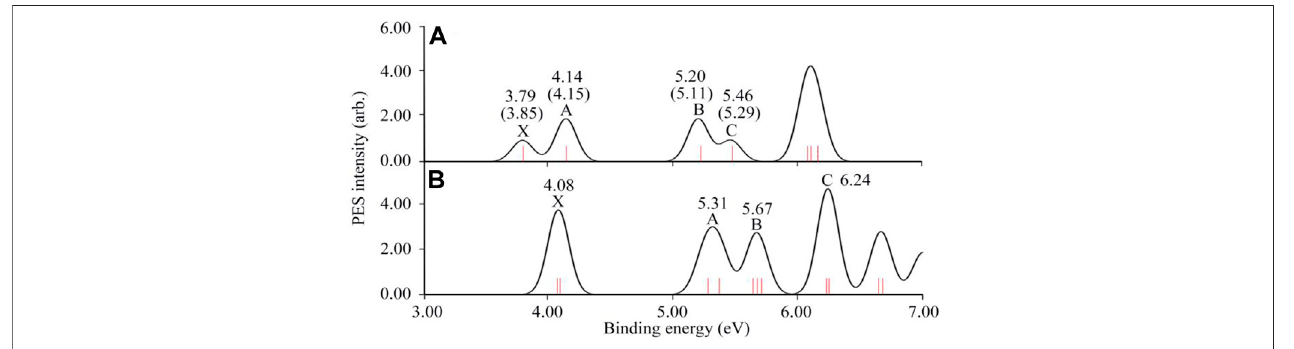
FIGURE5| Thesimulated photoelectronspectrumsof (A) RuB 9 − and (B) OsB 9 − werecalculated at theBP86/def2-TZVPPlevelbasedon generalized Koopmans ’ theorem. The experimental results of RuB 9 − are given in parenthesis.